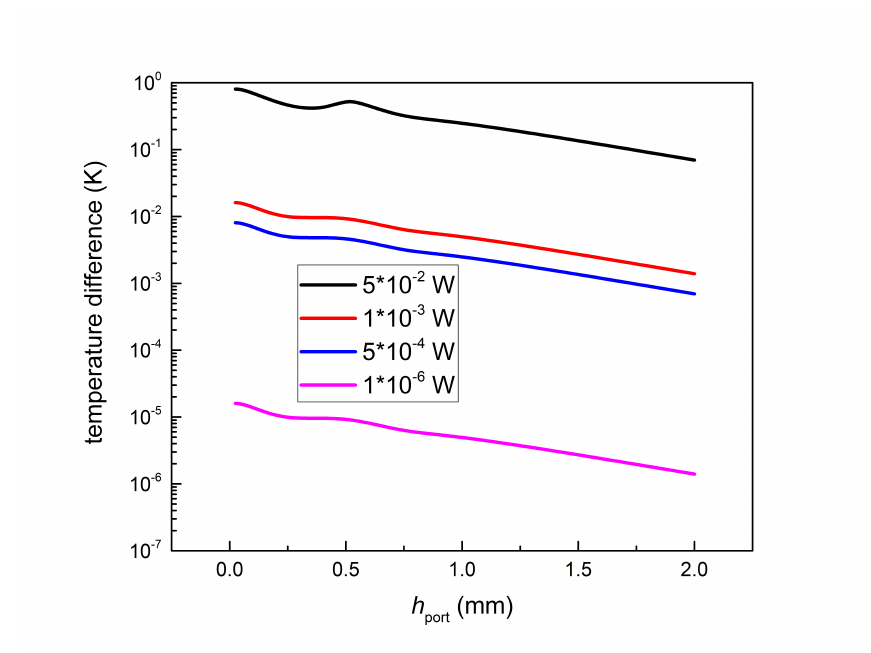
Figure 9. Temperature difference on h port at 0.4 THz; P ex values are listed in the